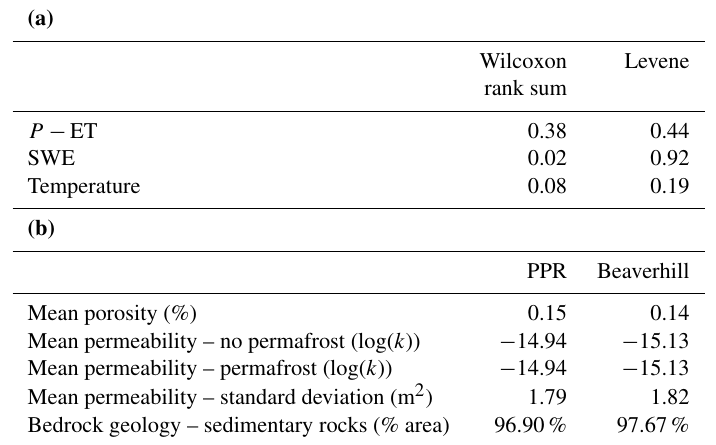
Table 2. Comparison of climate and geological features between Beaverhill watershed and the entire PPR. (a) p values of the Wilcoxon rank sum and Levene tests that were used to assess the similarities in median and variance, respectively, between monthly averaged climatic measures in the Beaverhill watershed and the entire PPR. These statistical analyses were conducted based on 31 years (from 1981 to 2011) of precipitation minus actual evapotranspiration ( P − ET), snow water equivalent (SWE) and air temperature data. p values greater than 0.10 indicate a similarity between climatic measures at a significance level of 0.10. (b) Comparison of the average values of geological features between Beaverhill watershed and the entire PPR. K (m 2 ) refers to